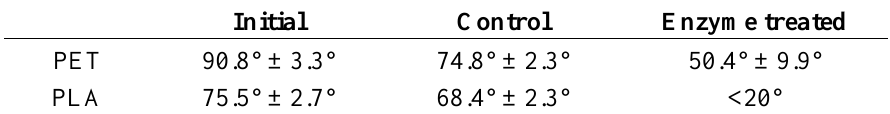
Table 2. Hydrophilicity increase (quantified as Water contact angle WCA decrease) of PET and PLA upon surface hydrolysis with the esterase